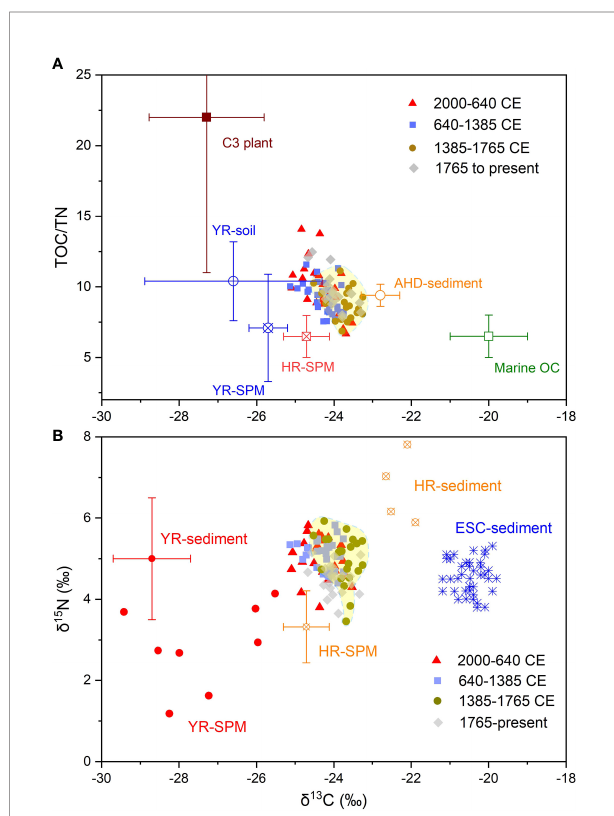
FIGURE 8 | TOC/TN ratios vs d 13C (A) and d 15N vs d 13C (B) for sediment samples and possible OM sources.) Kao et al., 2003; Kubota et al., 2015 (Liu et al., 2003; Qiu et al., 2007; Wang et al., 2015; Wang et al., 2018; Sun et al., 2020a; Sun et al., 2020b; Yan et al.,